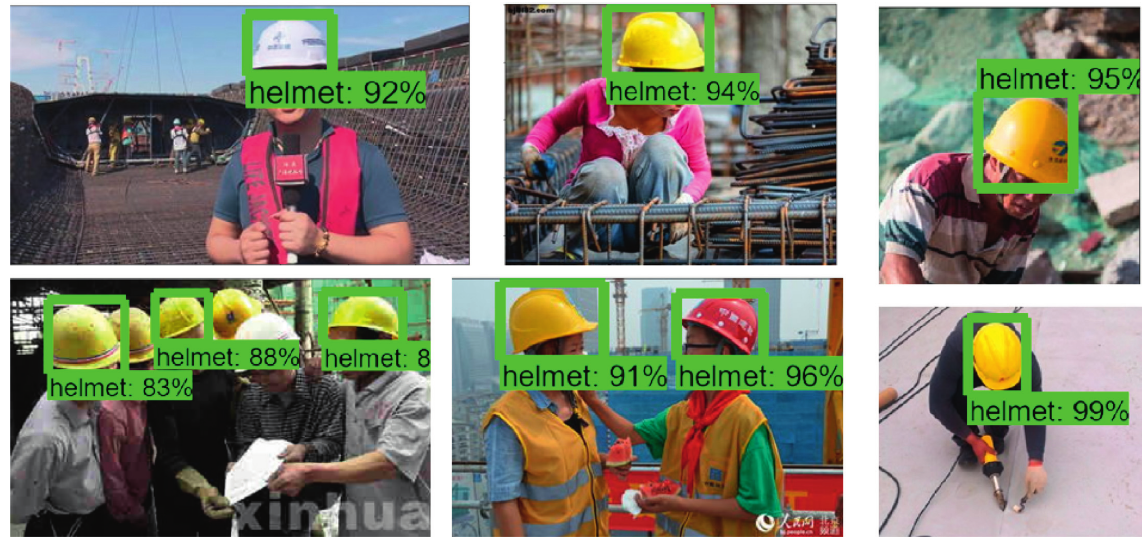
Figure 9: Validation